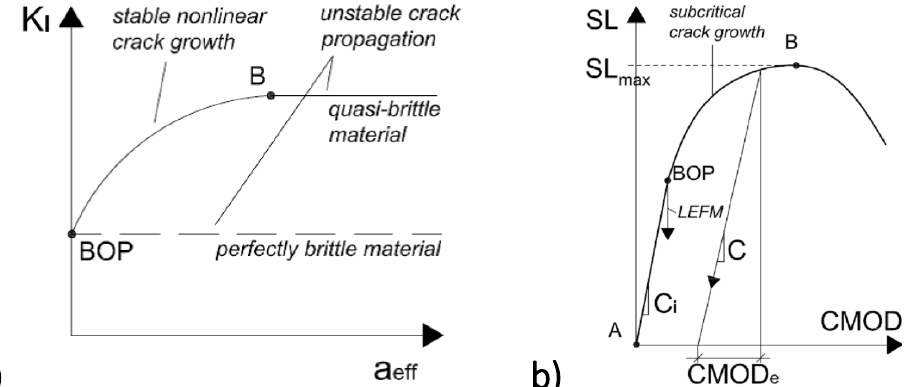
Figure 4. ( a ) Typical crack-growth-resistance curves of brittle and quasi-brittle materials and ( b ) typical response of quasi-brittle materials under CDCB test [15].